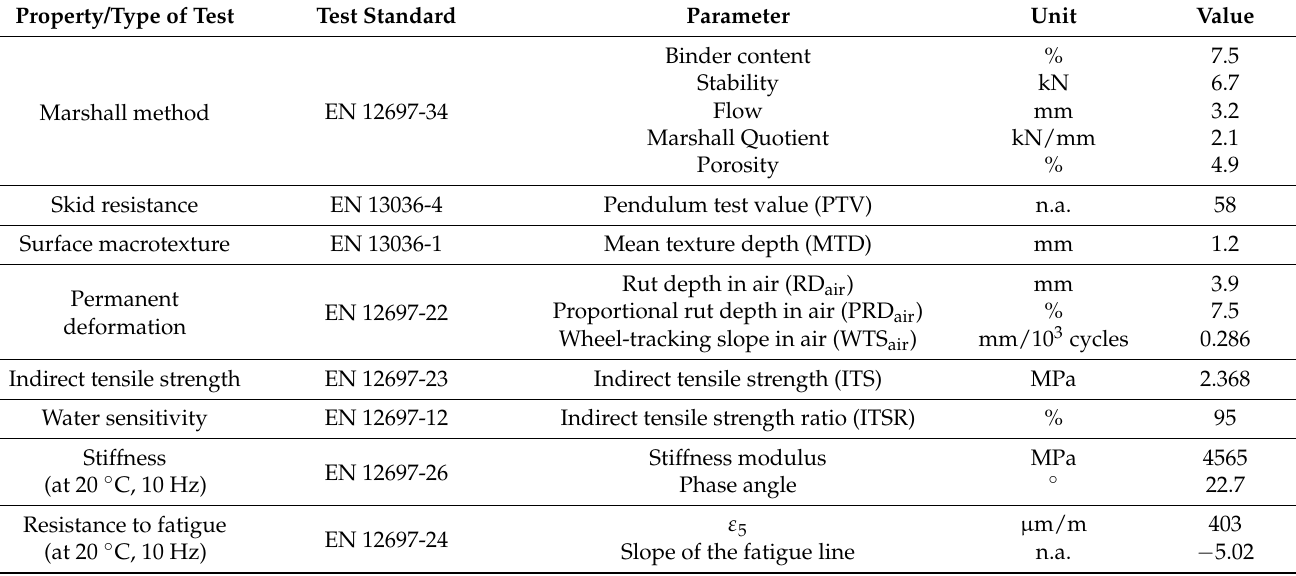
Table 1. Properties of the control mixture.